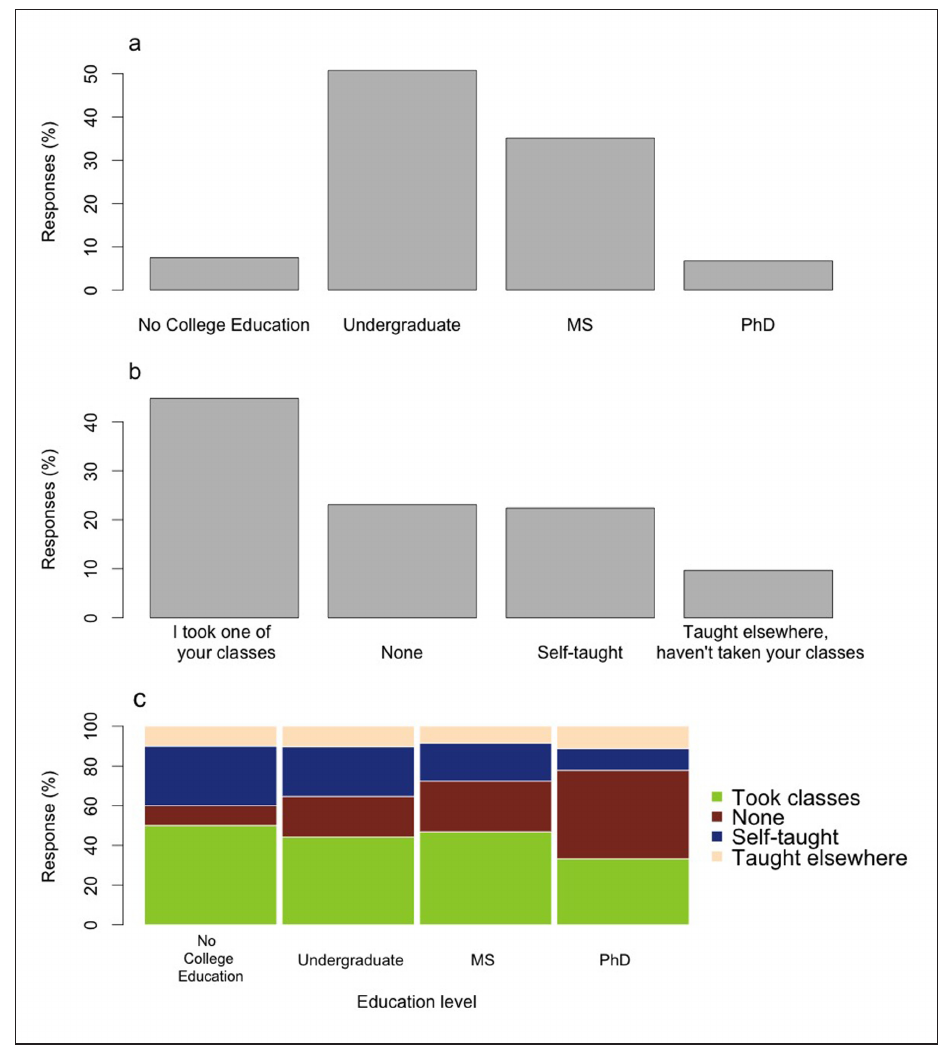
Figure 3: Educational attainment and experience of study volunteers. We queried registrants ( n = 128 ) to determine their (a) educational attainment and (b) experience with pollinator identification. (c) The frequency of each attainment level crossed with each experience